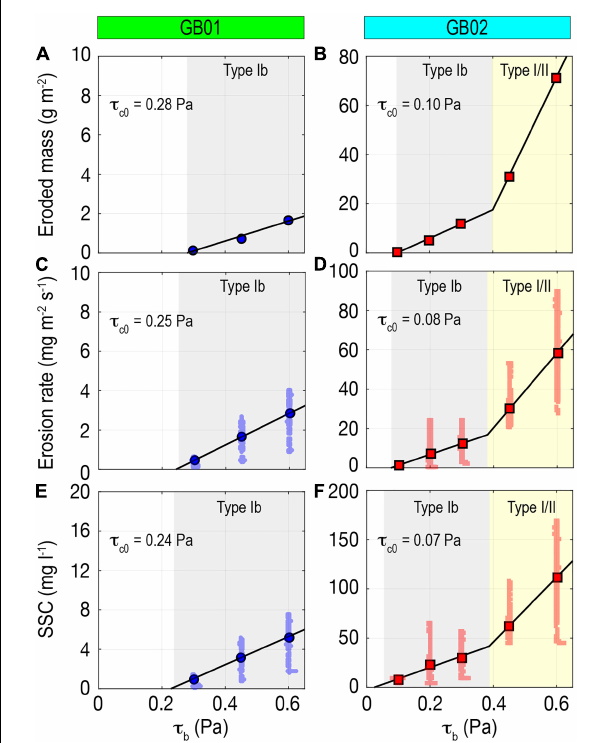
FIGURE 4 | Plots used in the determination of surface erosion threshold ( τ c0 ) in GB01 (A,C,E) and GB02 (B,D,F) at the end of emersion during S2 period (see Figure 2A ): eroded mass (A,B) , erosion rate (C,D) , and SSC (E,F) as a function of applied bed shear stress ( τ b ), respectively. Blue dots and red squares indicate mean values at each step of τ b . Black solid lines indicate the fitting of regression line. Area of light gray indicates the erosion of type Ib. N.D., not